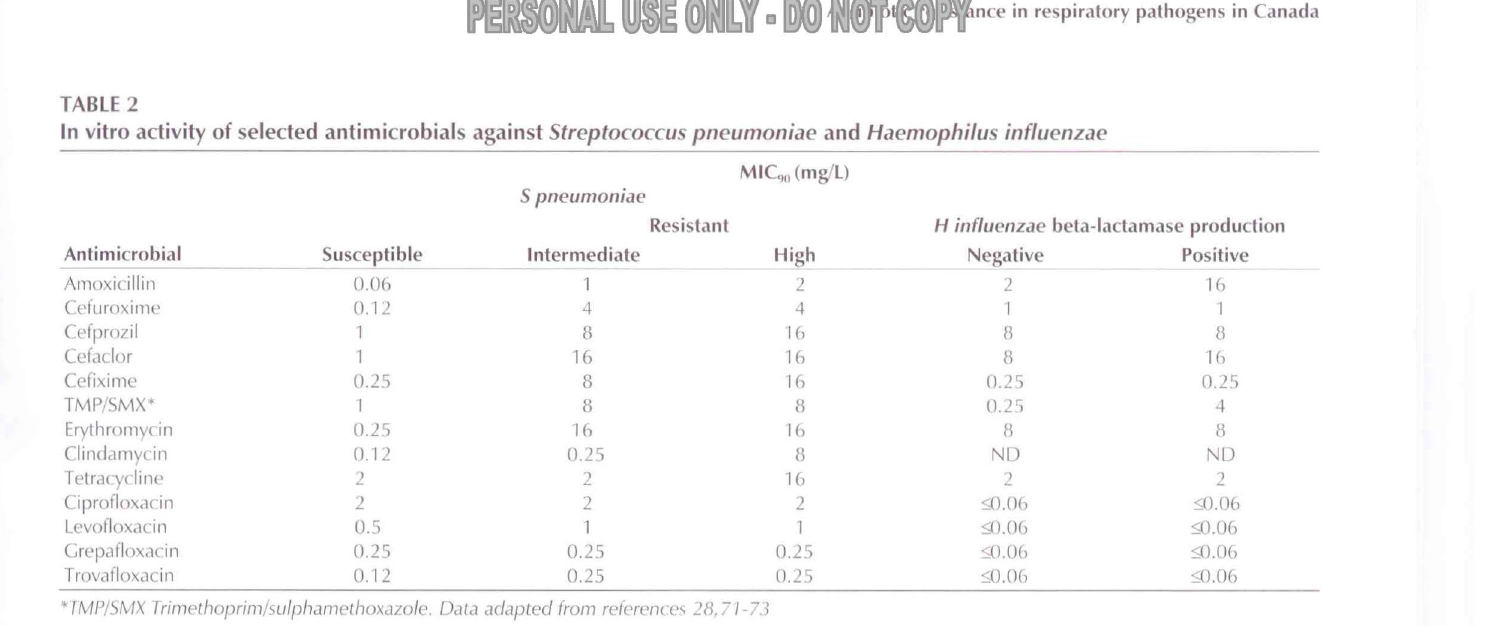
Relationship between penicillin susceptibility categories in Streptococcus pneumoniae and resistance of the organism lo other antimicrobials or classes of